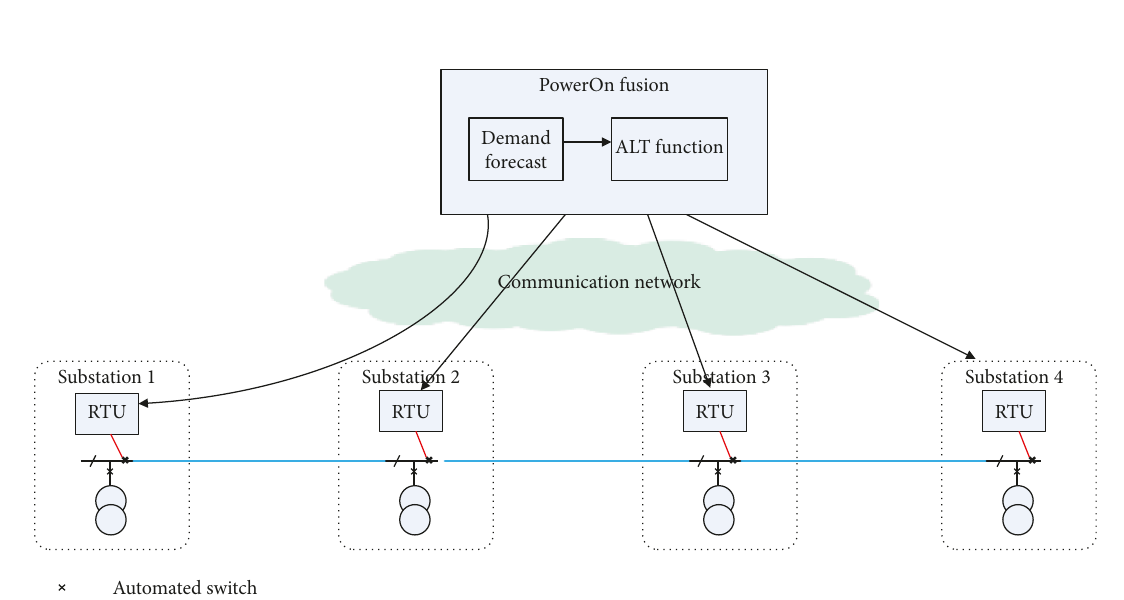
Figure 1: DAR trial schematic.